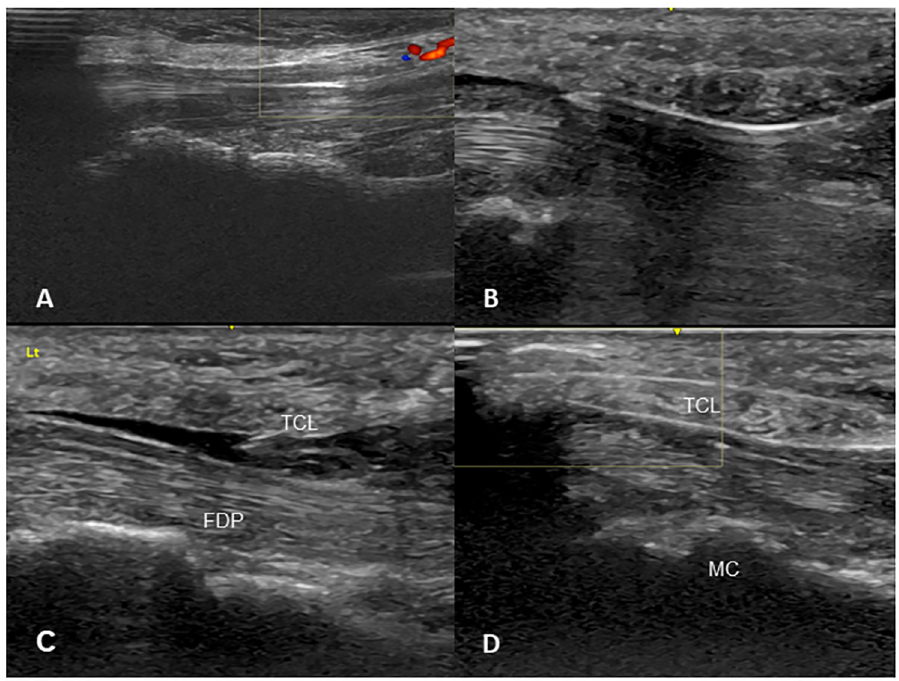
Fig 3. Ultrasound images of the carpal tunnel visualized during TCTR procedure. A: Anatomical landmark “duck’s beak”. B: Entry of 18G Tuohy epidural needle. C: Hydrodissection of carpal tunnel. D: Smartwire-01 looped around TCL. Abbreviations: TCL, transverse carpal ligament; MC, metacarpal bone; FDP, flexor digitorum profundus muscle.